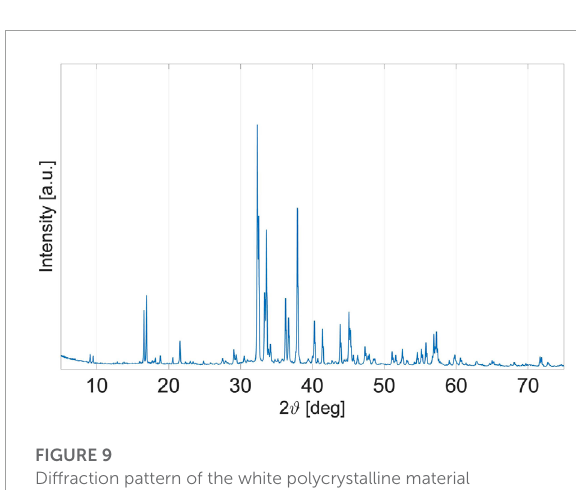
FIGURE 9 Diffraction pattern of the white polycrystalline material superficially growing on geopolymeric specimens exposed to air during